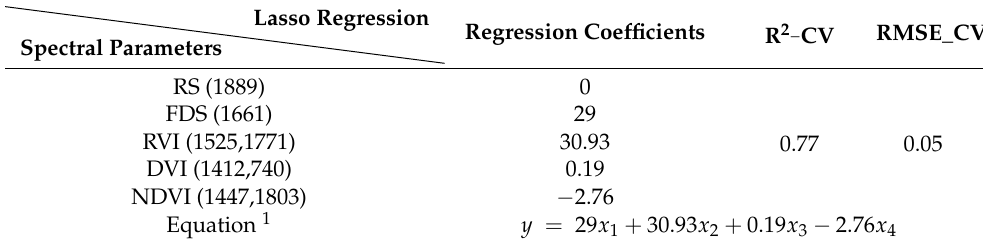
Table 3. Correlation coefficients between existing vegetation indices and leaf water